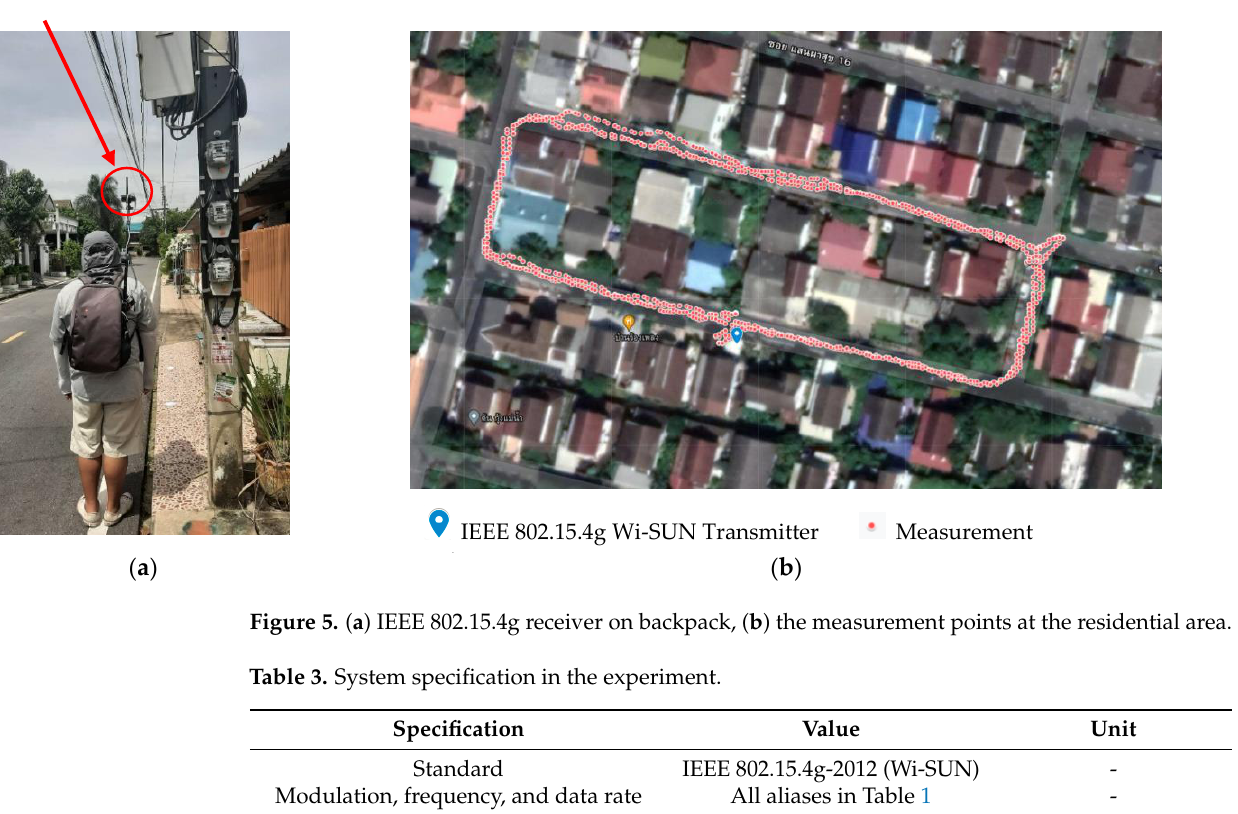
Figure 4. IEEE 802.15.4g Wi-SUN development board modelled LAUNCHXL-CC1352P.